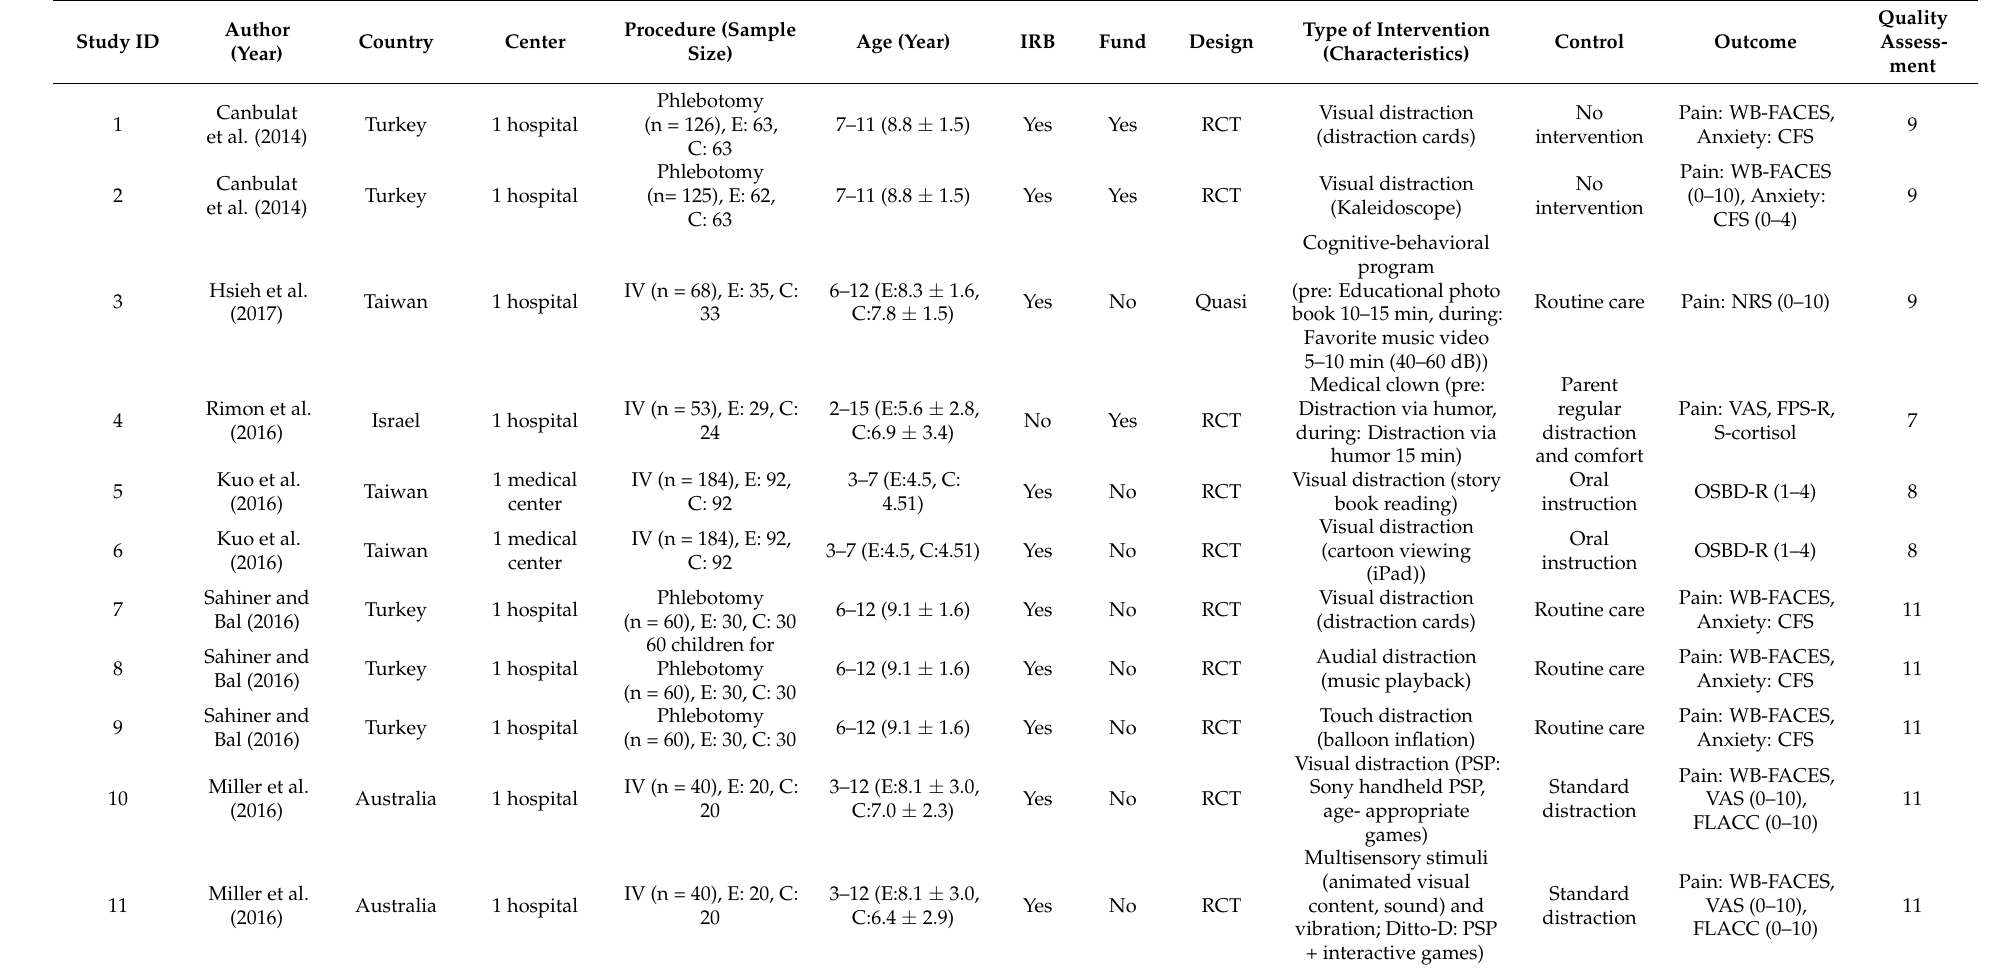
Table 1. Characteristics of the included